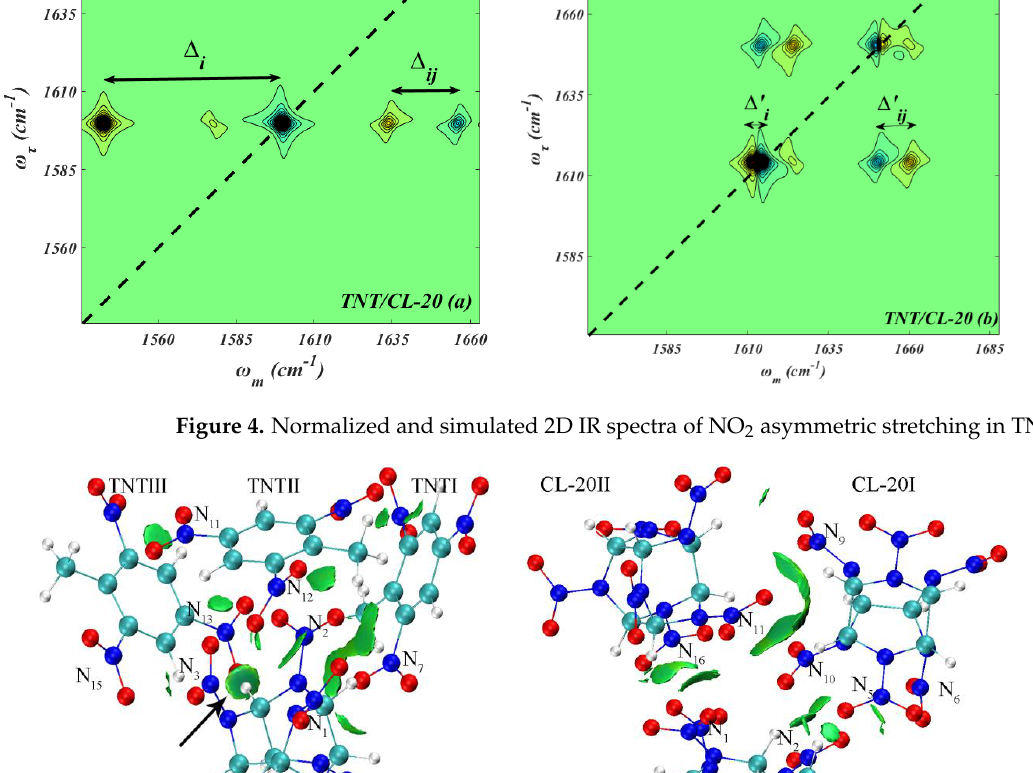
Figure 3. Normalized and simulated 2D IR spectra and corresponding IR spectra (top panel) of NO 2 asymmetric stretching in TNT/CL-20 ( left ) and HMX/CL-20 ( right ).